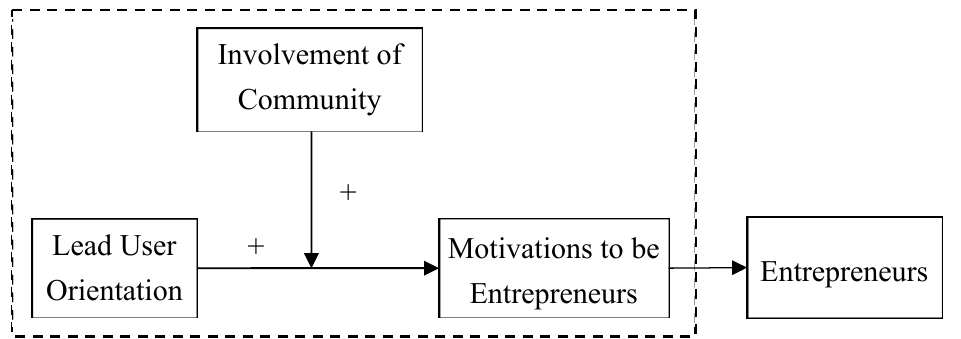
Figure 1. Research framework.